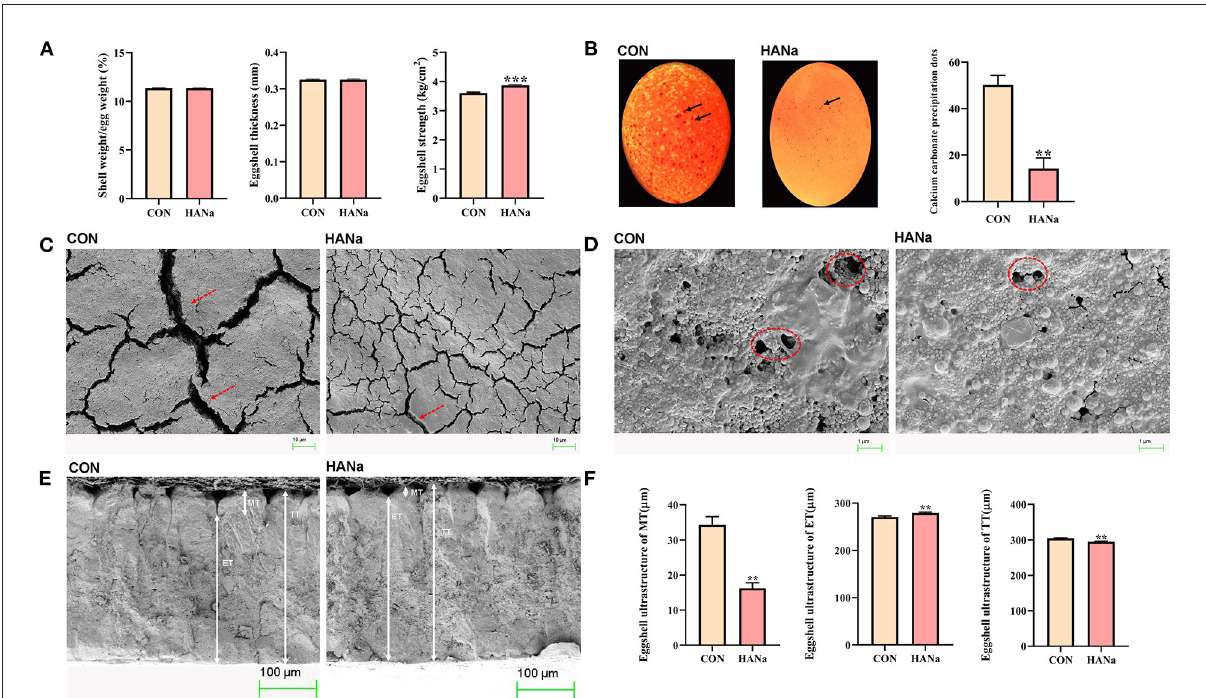
FIGURE3 Effect of sodium humate on eggshells. (A) Egg and eggshell quality in laying hens. (B) Precipitation of calcium carbonate on the surfaces of eggshells. (C) Observation of the ultrastructure of the eggshell surfaces in 1.00 KX. (D) Observation of the ultrastructure of eggshell surfaces in 10.00 KX. (E) Observation of the ultrastructure of eggshell cross-sections. (F) Effects of sodium humate on eggshell ultrastructure. Solid black arrows, calcium carbonate precipitation on the eggshell surface; red dashed arrows, cracks on the eggshell surface; red dashed circles, stomata on the eggshell surface. MT, mammillary layer thickness; ET, effective layer thickness; TT, total thickness. ** p ≤ 0.01 and *** p ≤